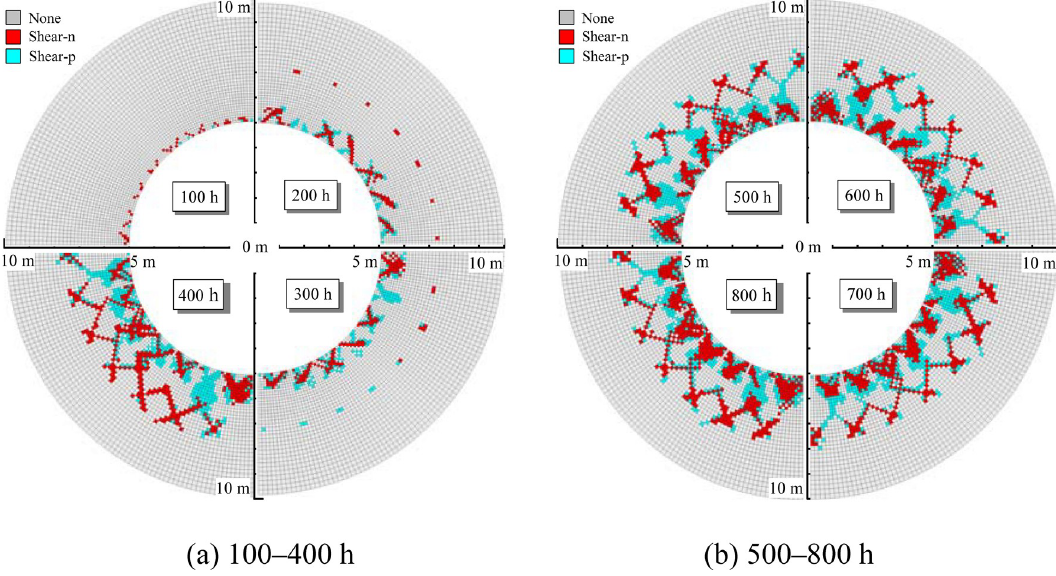
Fig 17. Plastic zone distribution characteristics of surrounding rock under anchor rod support. (a) 100–400 h (b) 500–800